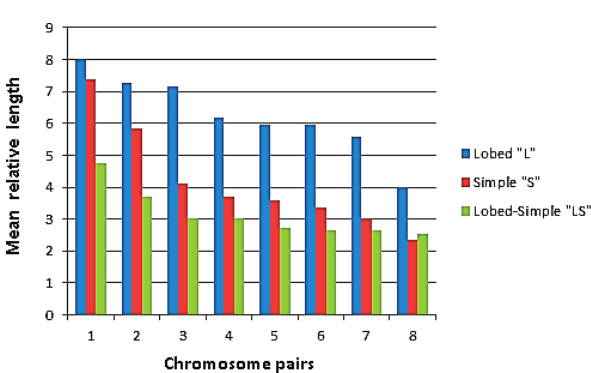
Fig. 4. Mean relative length (MRL) of each chromosome pair in the three studied genotypes of C.